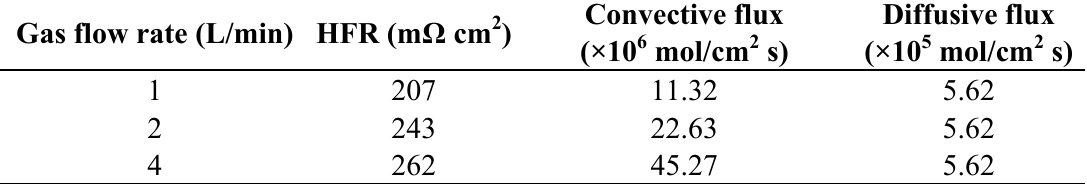
Table 3. Rate of removal of water at various flow rates of purging gas.